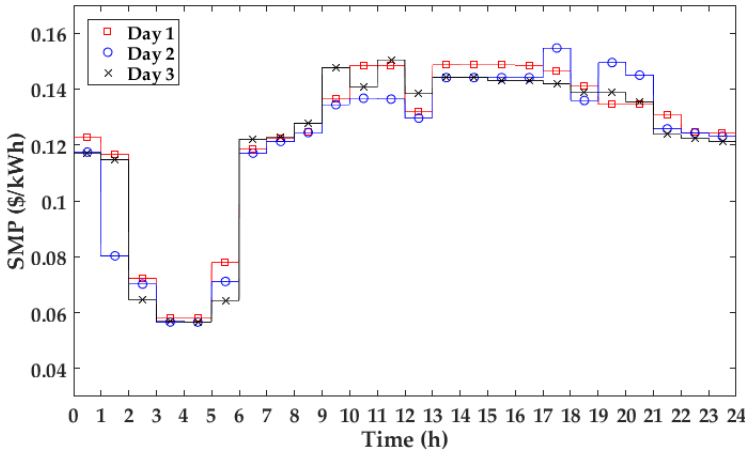
Figure 6. SMP profile for three days.